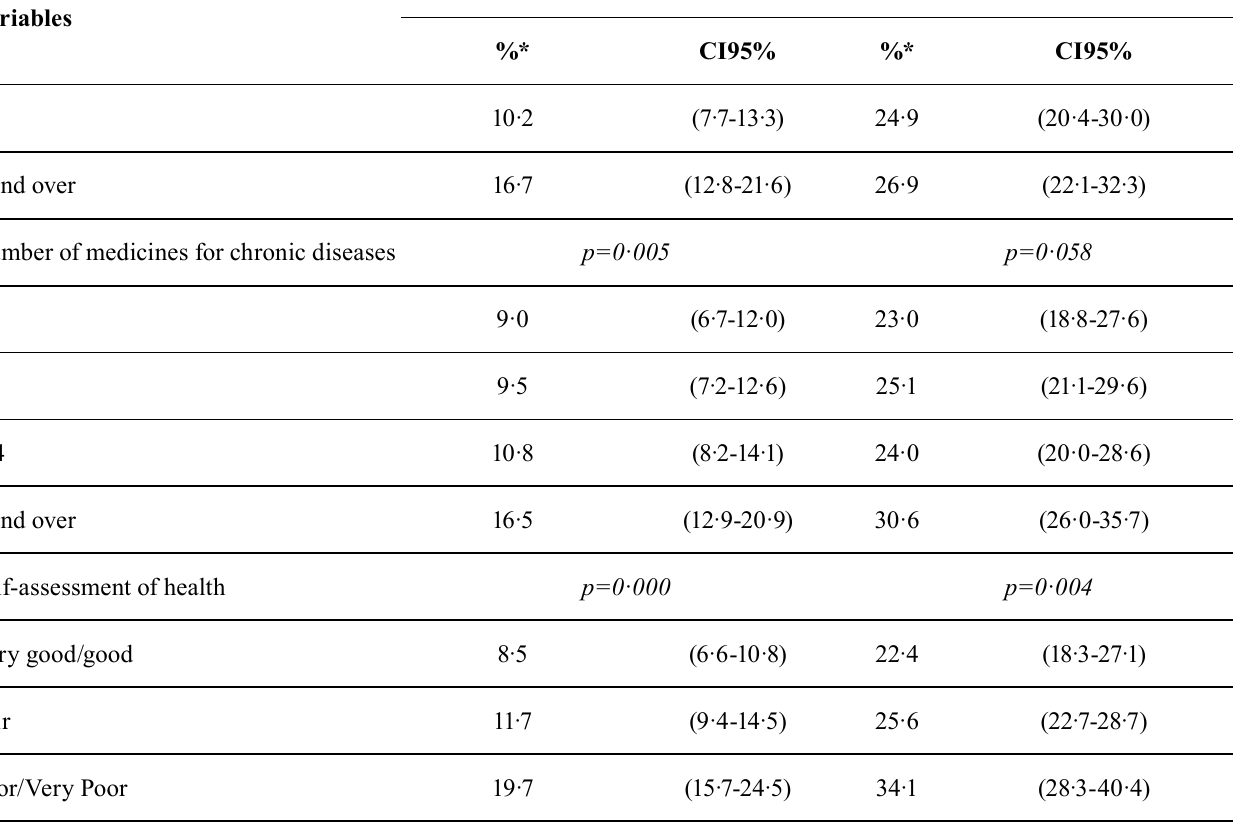
TABLE II – Difficulties of geographical accessibility to SUS pharmacy services among adult and elderly (20 years and over) users of the Unified Health System (SUS) with a reported chronic noncommunicable disease (NCD), indication of medicine treatment and that obtain some of the medicines in use in the SUS, according to demographic, socioeconomic and health variables. PNAUM, 2014 (N=5,155)